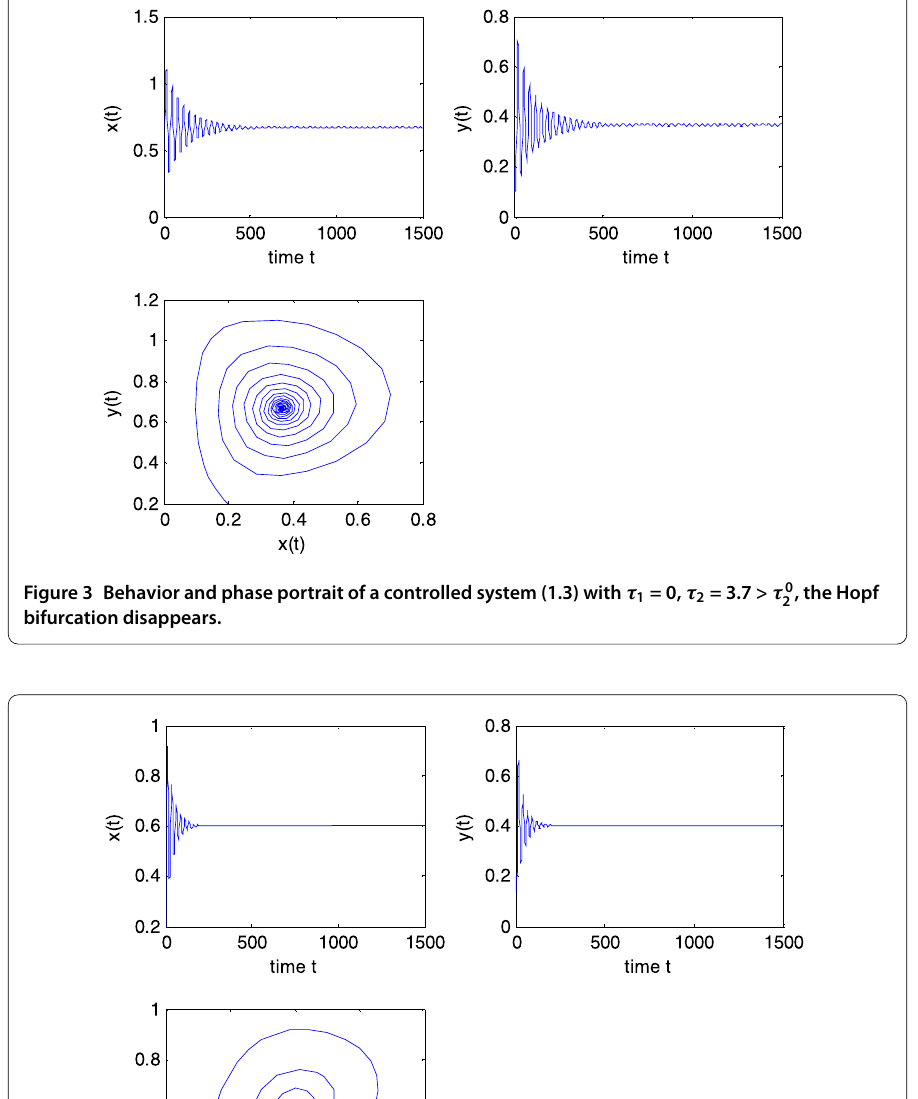
Figure 4 Behavior and phase portrait of a controlled system (1.3) with τ 1 = 0.8 > τ 0 Hopf bifurcation disappears.